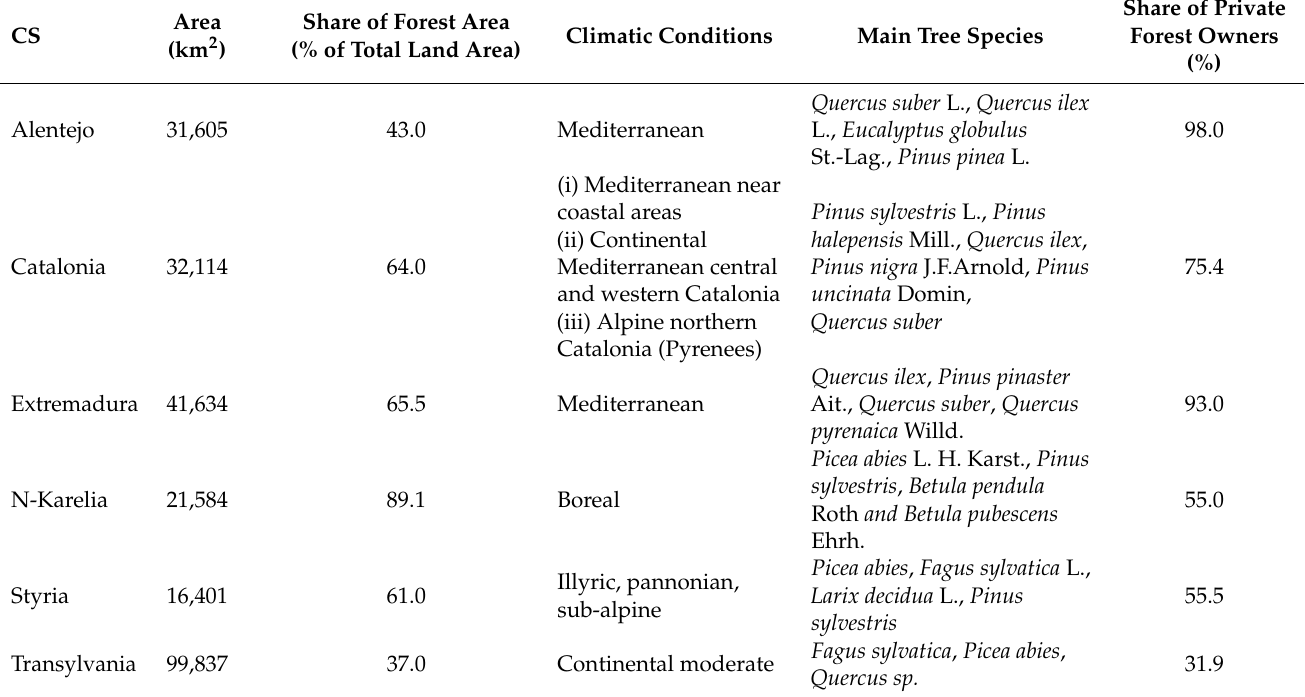
Table 1. Ecological and socio-economic characterisation of case